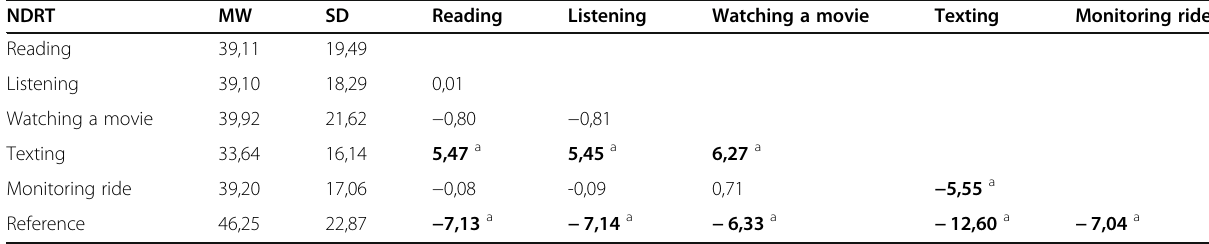
Table 2 Overview of the results HRV in ms